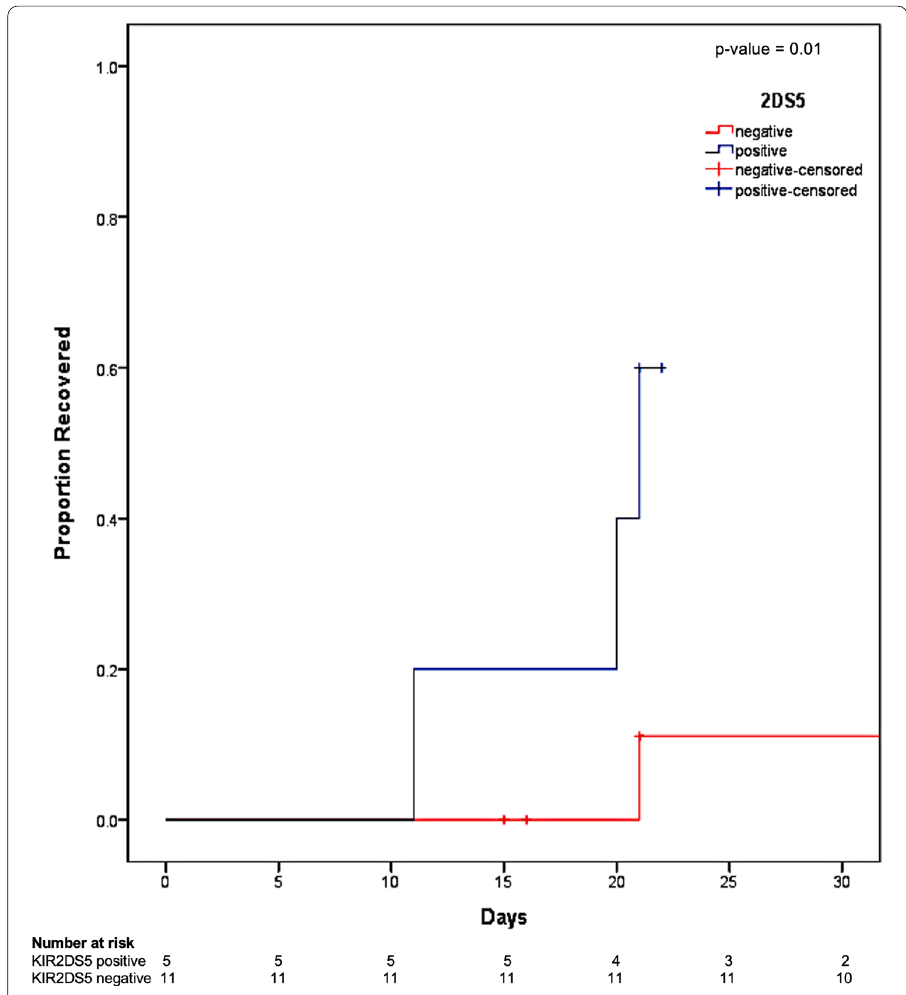
Fig. 2 Kaplan–Meier estimates on recovery regarding KIR2DS5 status. Cumulative estimates on recovery from COVID‑19‑related severe ARDS showing significantly higher proportion of recovery in KIR2DS5‑positive